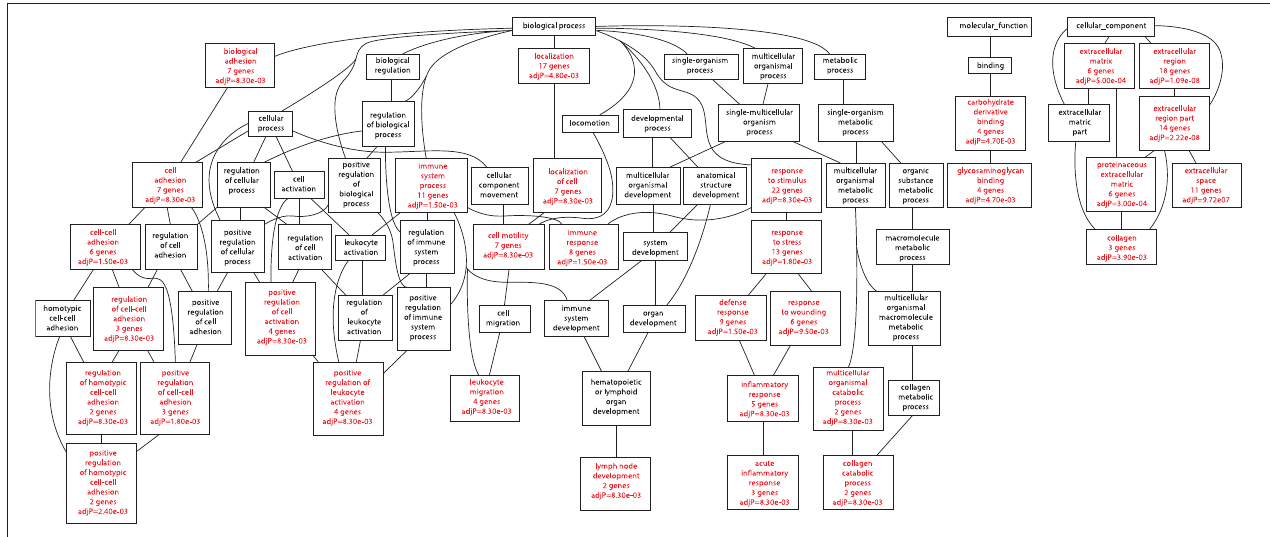
FIGURE 9 | Biological processes impacted by up-regulated genes in animals infected with strain 48 compared with animals infected with strain 48V at day 21 postinfection.